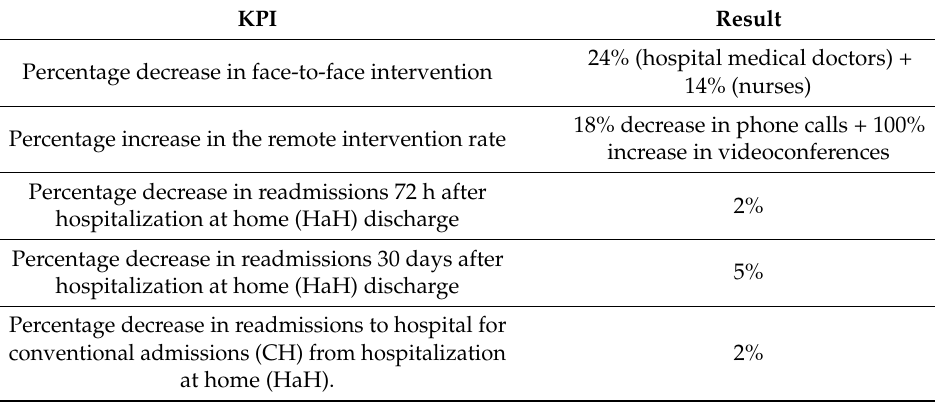
Table 7. Results of the evaluation of KPIs for feasibility.